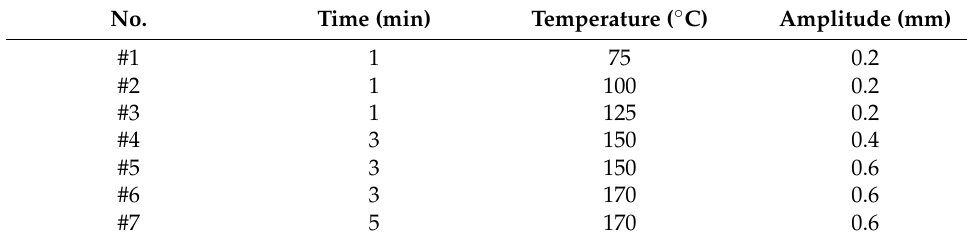
Table 5. Residual stress control parameters.